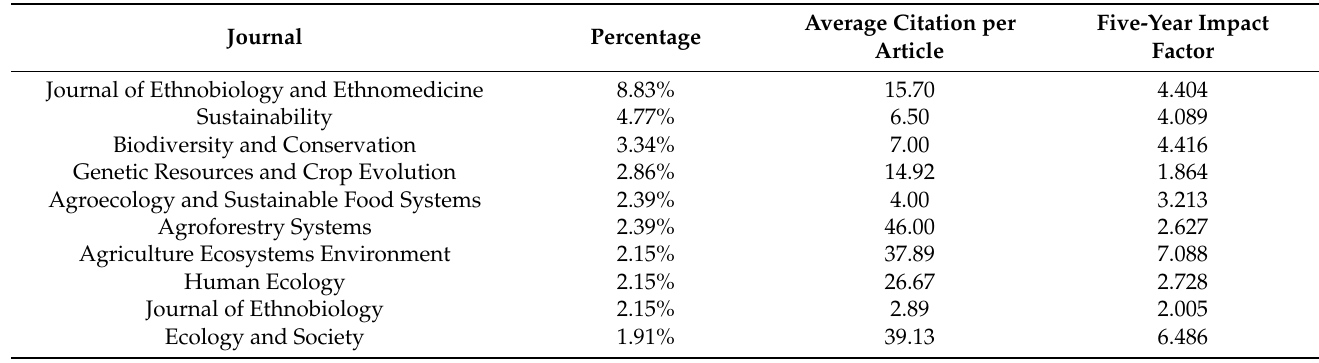
Table 2. Top 10 journals in a number of